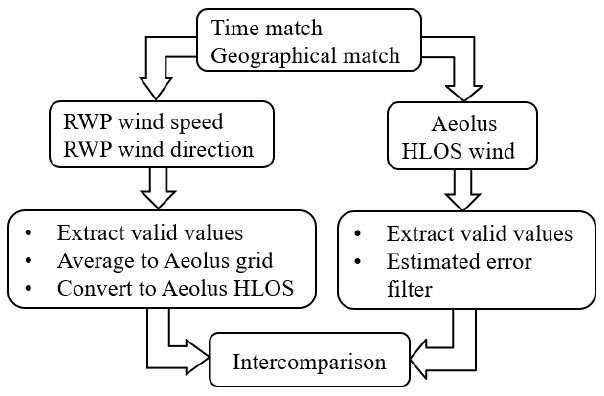
Figure 2. Flowchart of the processing procedures used to compare the RWP observations with Aeolus